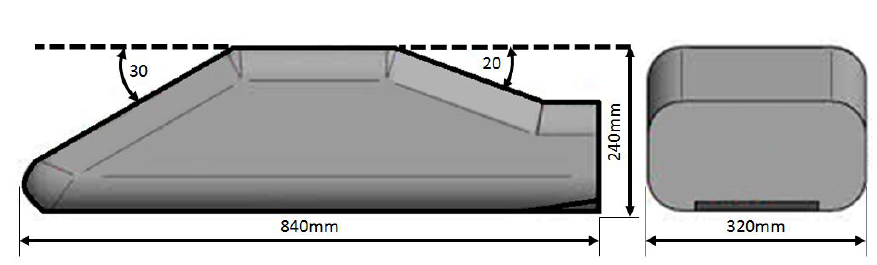
Figure 1. Illustration of the main dimensions of the 20 ◦ SAE Notchback body